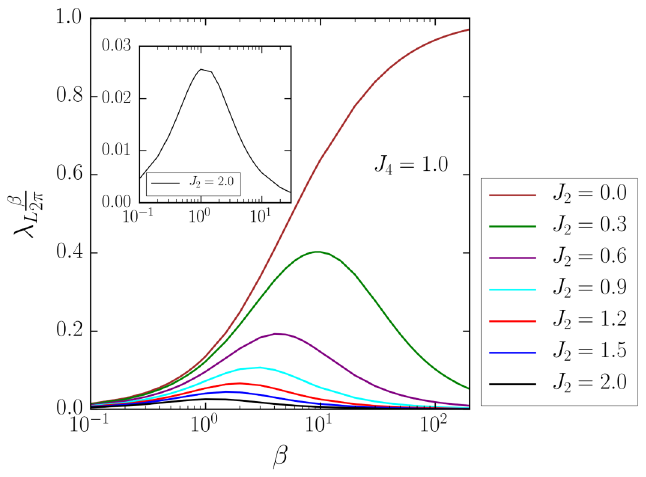
Figure 10. Plots of the normalized Lyapunov exponent as a function of inverse temperature β for different values of J 2 . For all the plots, J 4 = 1